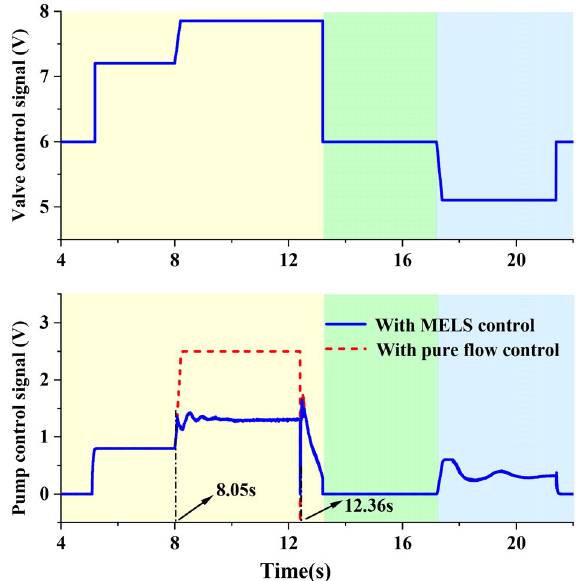
Figure 6 Control signals of the valve and pump